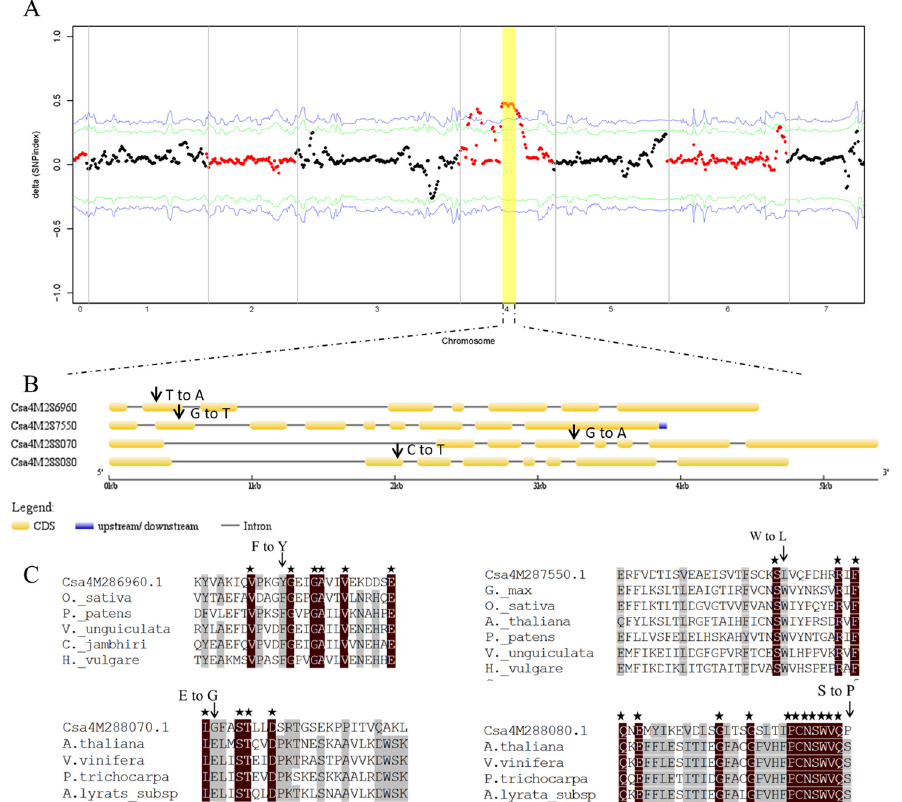
Figure 3. Identification of the gene conferring the yellow-green phenotype. ( A ) Δ (SNP-index) distribution of the 1402 and ygl1 pools. The x axis represents the position of seven chromosomes, and the y axis represents the Δ (SNP-index). The arrow and yellow rectangle indicate the region of chromosome 4 with a Δ (SNP-index) of approximately 0.5. The statistical confidence interval under the null hypothesis of no QTLs (Quantitative Trait Locus) was indicated as green ( p < 0.05) and blue ( p < 0.01). ( B ) Gene structure of Csa4M286960 , Csa4M287550 , Csa4M288070 , and Csa4M288080 . The black vertical line represents the mutations. ( C ) Alignment of the LOX genes from diverse species with Csa4M286960 , Csa4M287550 , Csa4M288070 , and Csa4M288080 homologs. Amino acid residues displaying >50% identity or similarity between the homologs are shaded black or gray.